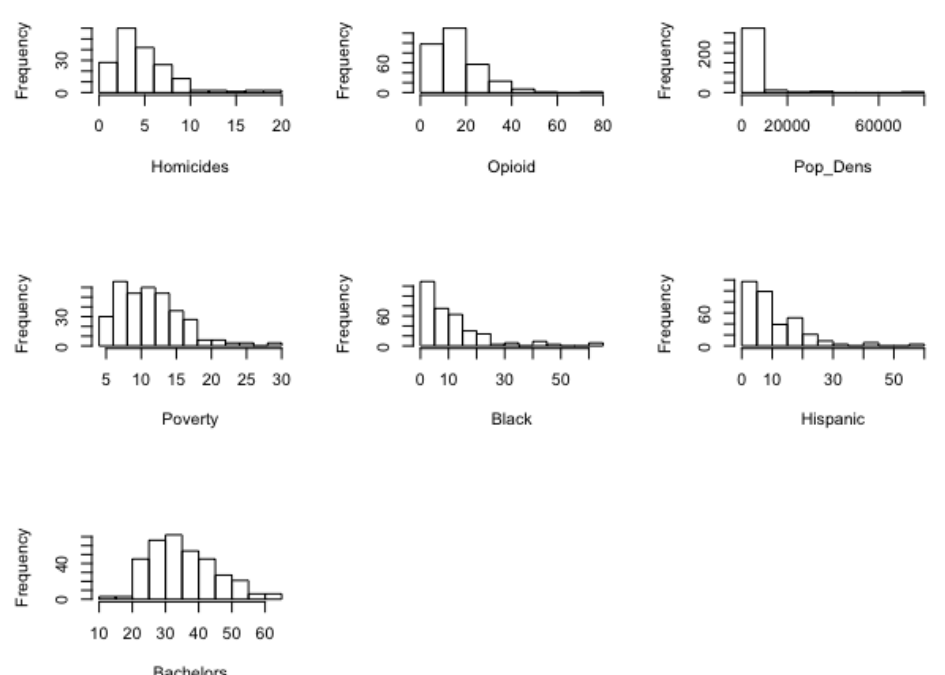
Figure A2. The distributions of urban county values of each of the numerical explanatory variables used in the model. Right skew is present in all data values, with Bachelors being the dataset closest to normal.